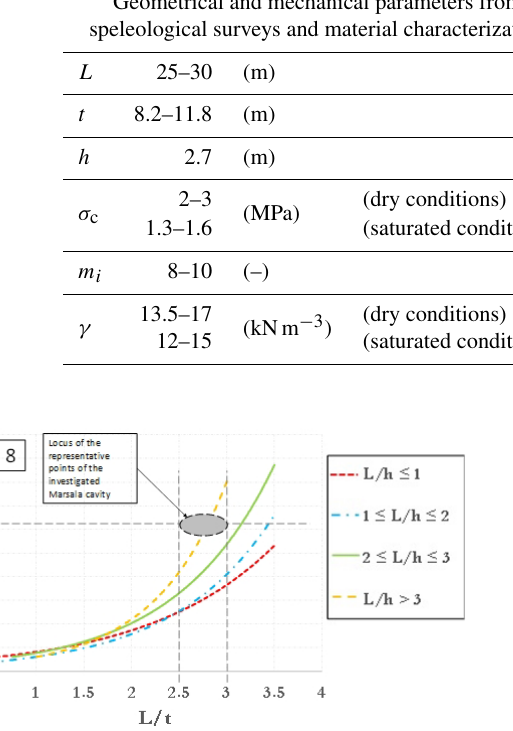
Figure 12. Application of stability chart ( m i = 8) for the Marsala underground